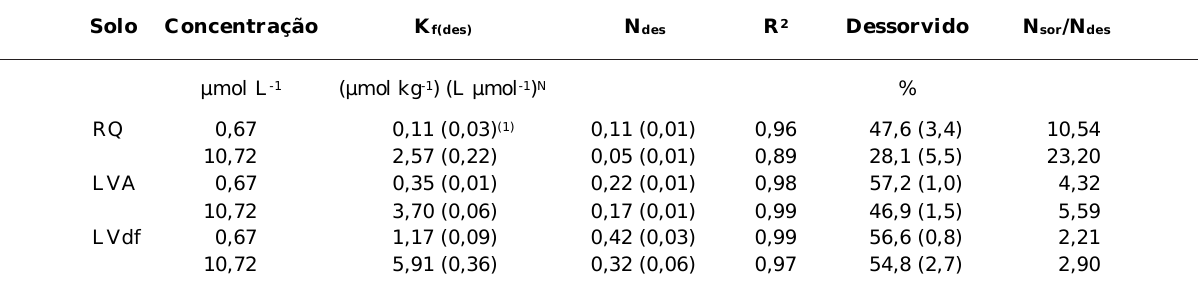
Quadro 3. Coeficiente de Freundlich para dessorção (K determinação (R 2 ), percentual dessorvido e índice de histerese (N de um Neossolo Quartzarênico (RQ), um Latossolo Vermelho-Amarelo (LVA) e um Latossolo Vermelho distroférrico